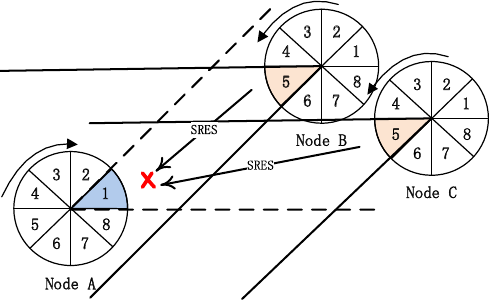
Figure 5. The second “link collision” problem-the collision of the second handshake.